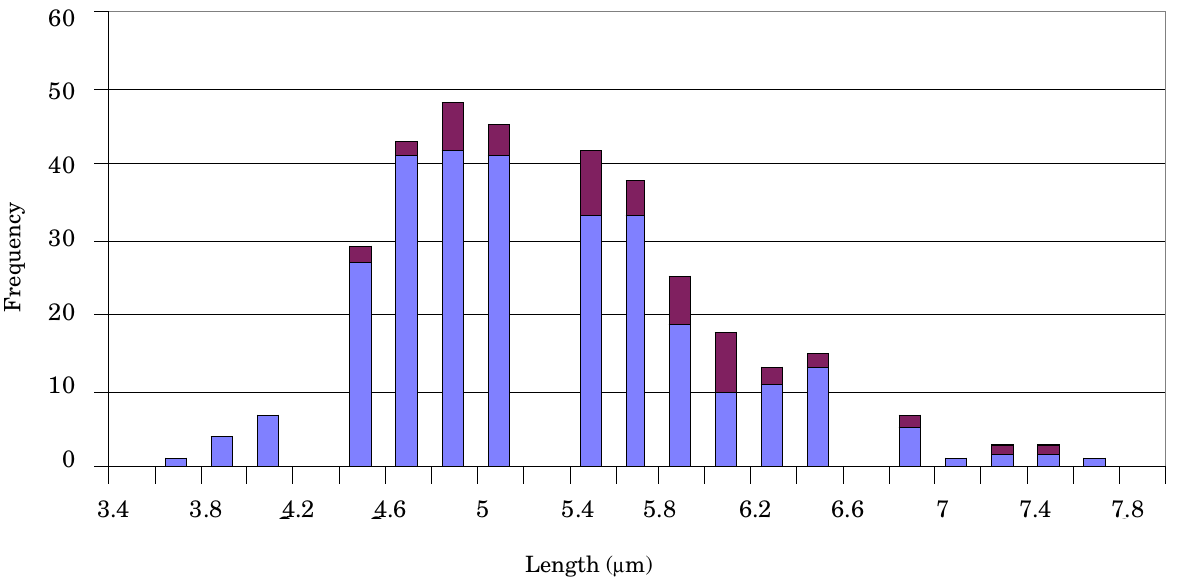
Fig. 6. Histogram of conidia length of strain EA II (a) 1 ( P. angustius ). Upper part of the bar, allantoid conidia; lower part of the bar, straight conidia.